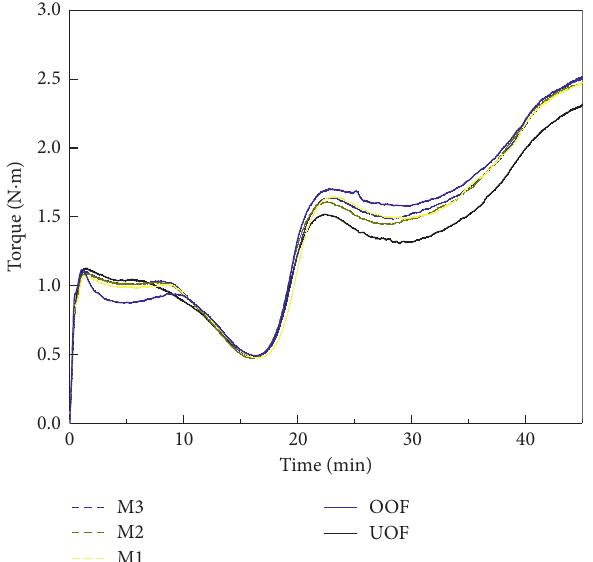
Figure 4: Mixolab curves of wheat flour added with different ratios of overozonized wheat flour.